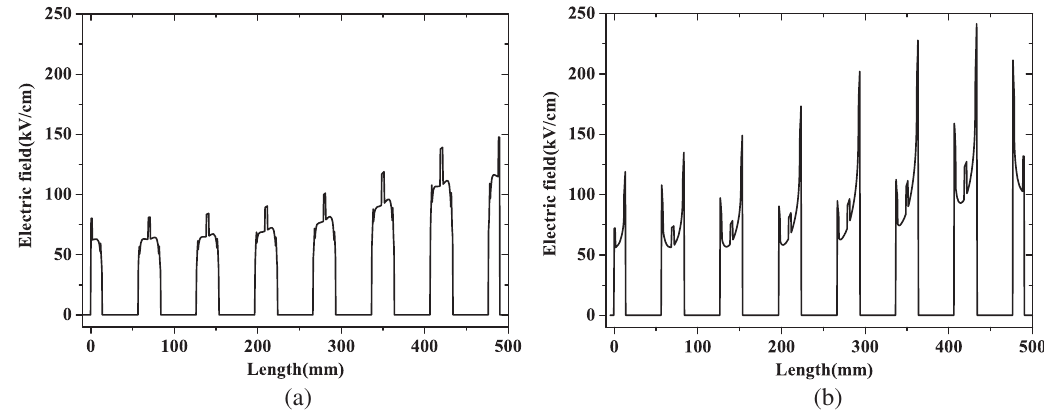
FIG. 7. Axial electric fields at the outmost of the magnetic cores (a) with metal bands and (b) without metal bands. The maximum electric field is about 150 kV = cm for the magnetic cores with metal bands, and the corresponding place is close to the azimuthal transmission line high voltage electrode ’ s